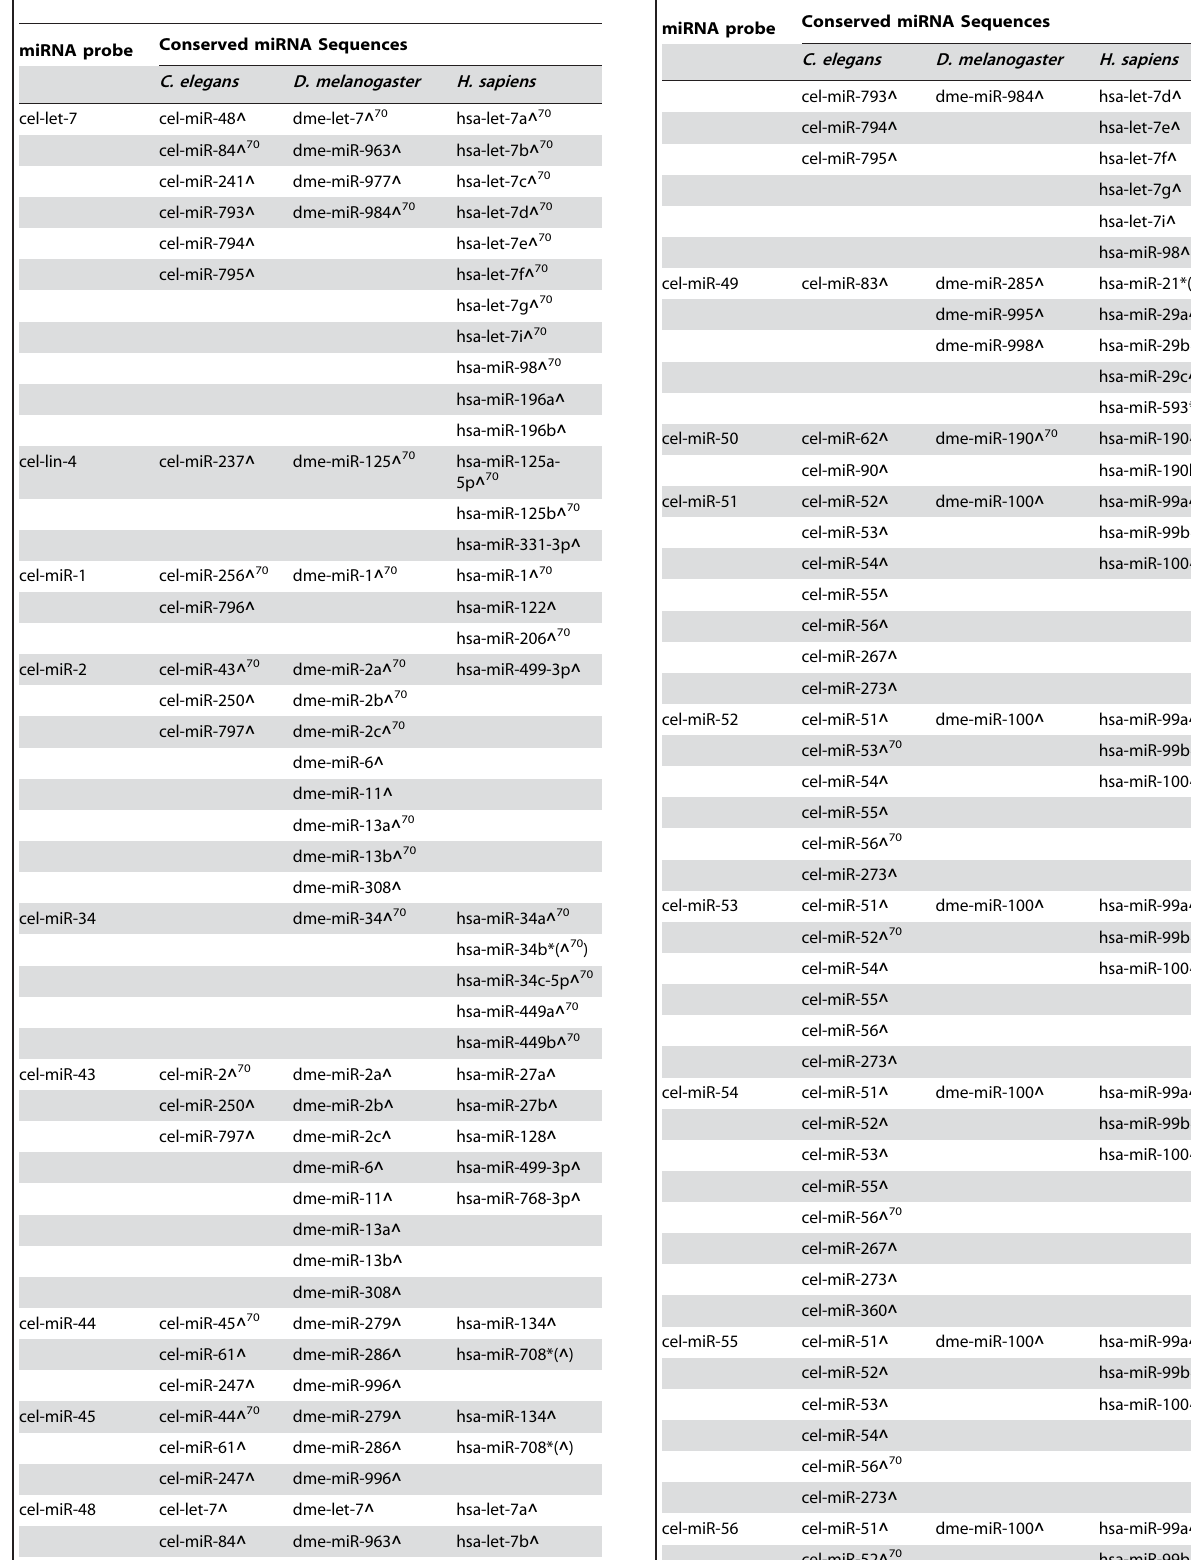
Table 6. C. elegans miRNAs conserved in D. melanogaster and H. sapiens